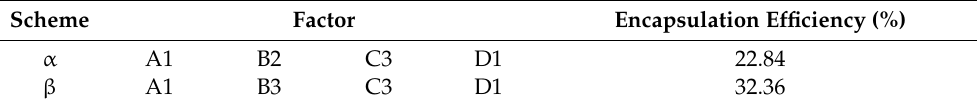
Table 5. Experimental results on IR780 encapsulation efficiencies of Scheme α and Scheme β .